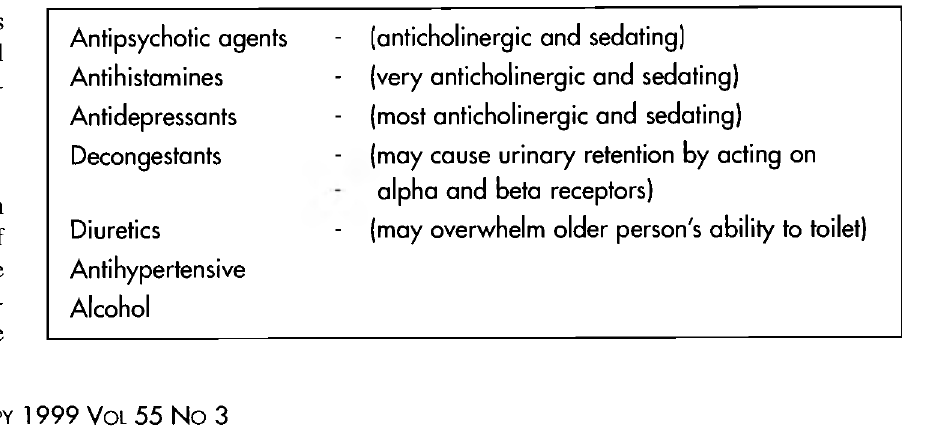
TABLE 1: DRUGS THAT MAY AFFECT CONTINENCE Antipsychotic agents - (anticholinergic and sedating) Antihistamines - (very anticholinergic and sedating) Antidepressants - (most anticholinergic and sedating) Decongestants - alpha and beta